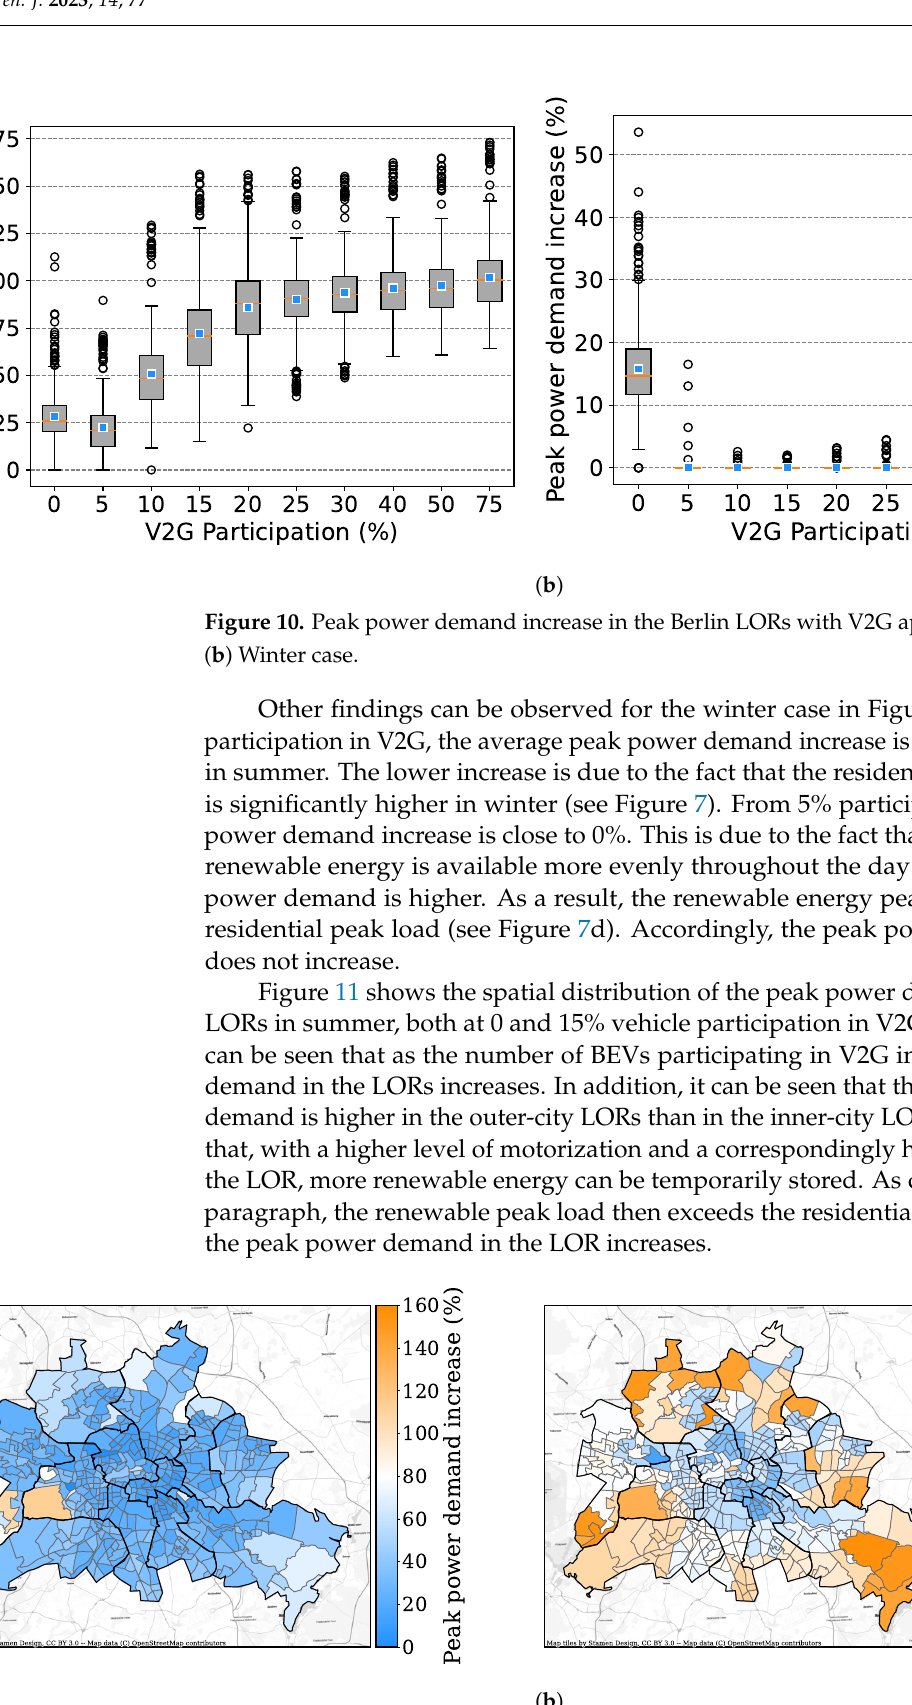
Figure 11. Spatial distribution of the peak power demand increase in Berlin LORs. Summer